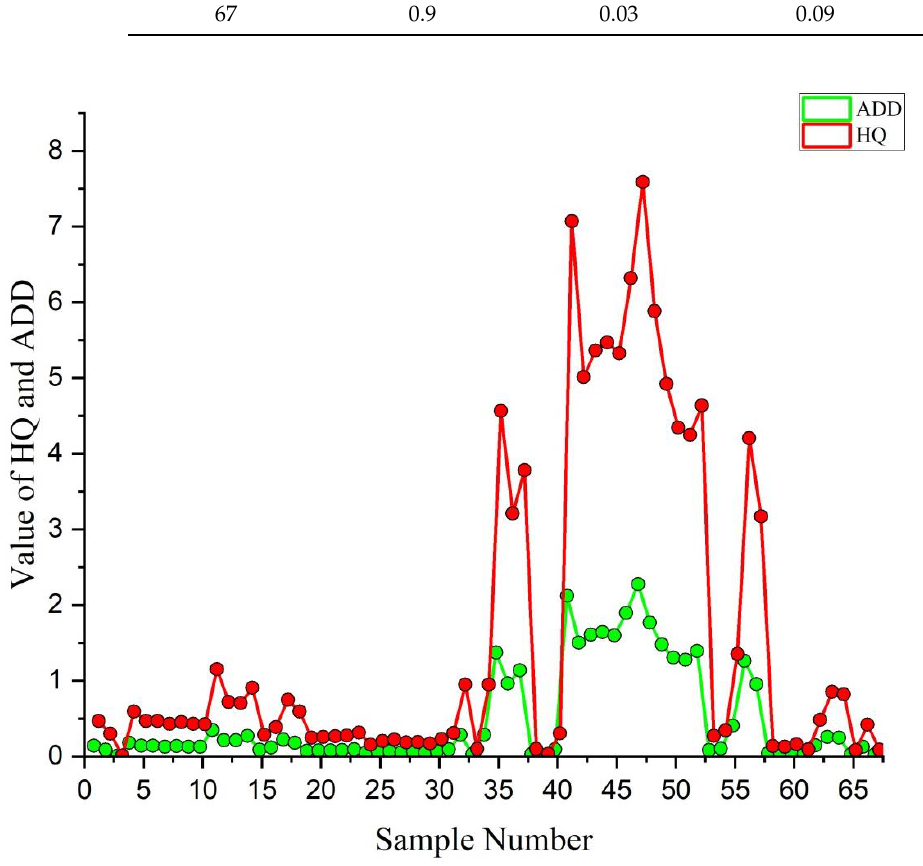
Figure 11. Range of ADD and HQ values in groundwater samples. Table 4. Average daily intake (mg/kg/day), hazard quotient, and cancer risk assessment results cal- culated for the groundwater of the research area.